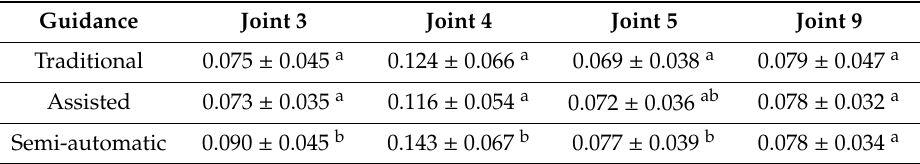
Table 3. The average joint speed (m / s) measured in the four joint points during the field tests. Guidance